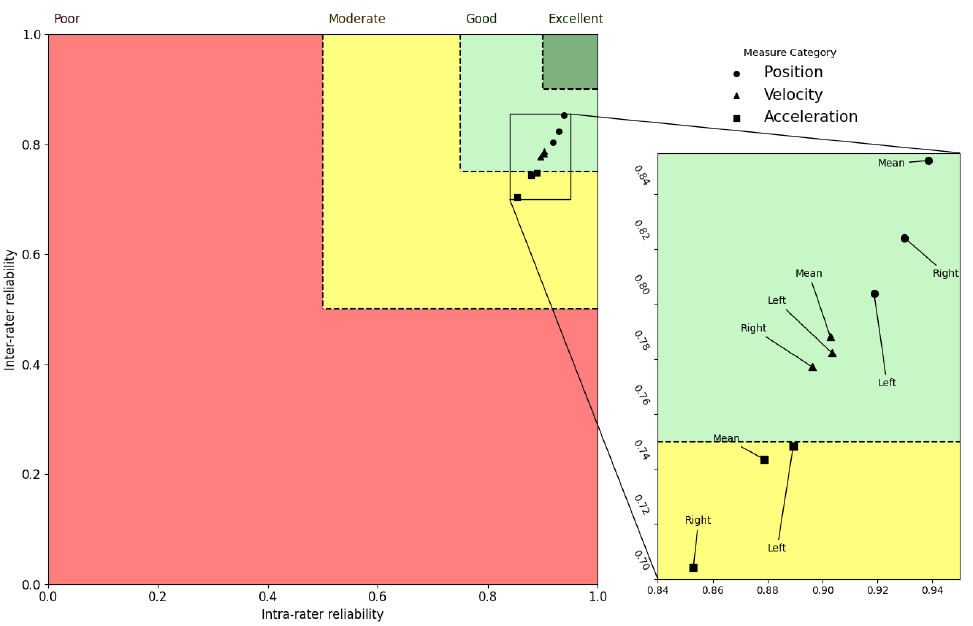
Figure 3. Lateral plane inter-rater vs. intra-rater reliability. Regions with poor, moderate, good, and excellent reliability are shown, respectively, in red, yellow, light green, and dark green. Circles, tri- angles, and squares are used to represent measures extracted from flexibility, velocity, and acceleration signals,